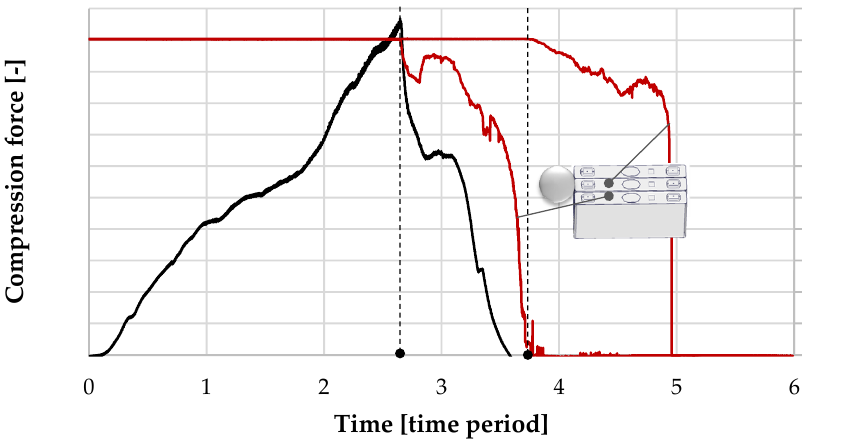
Figure 6. Compression force and state of charge over time for middle and right cell at test in v-direction with hemispherical impactor.